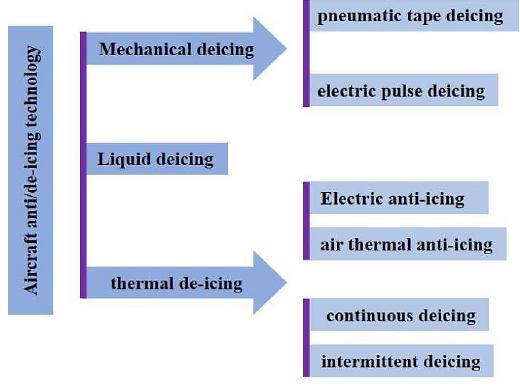
Figure 3. Aircraft anti/de-icing technologies.